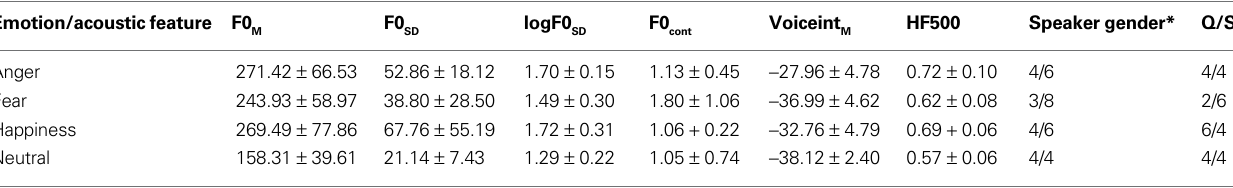
Table 1 | Selected acoustic features of prosodic